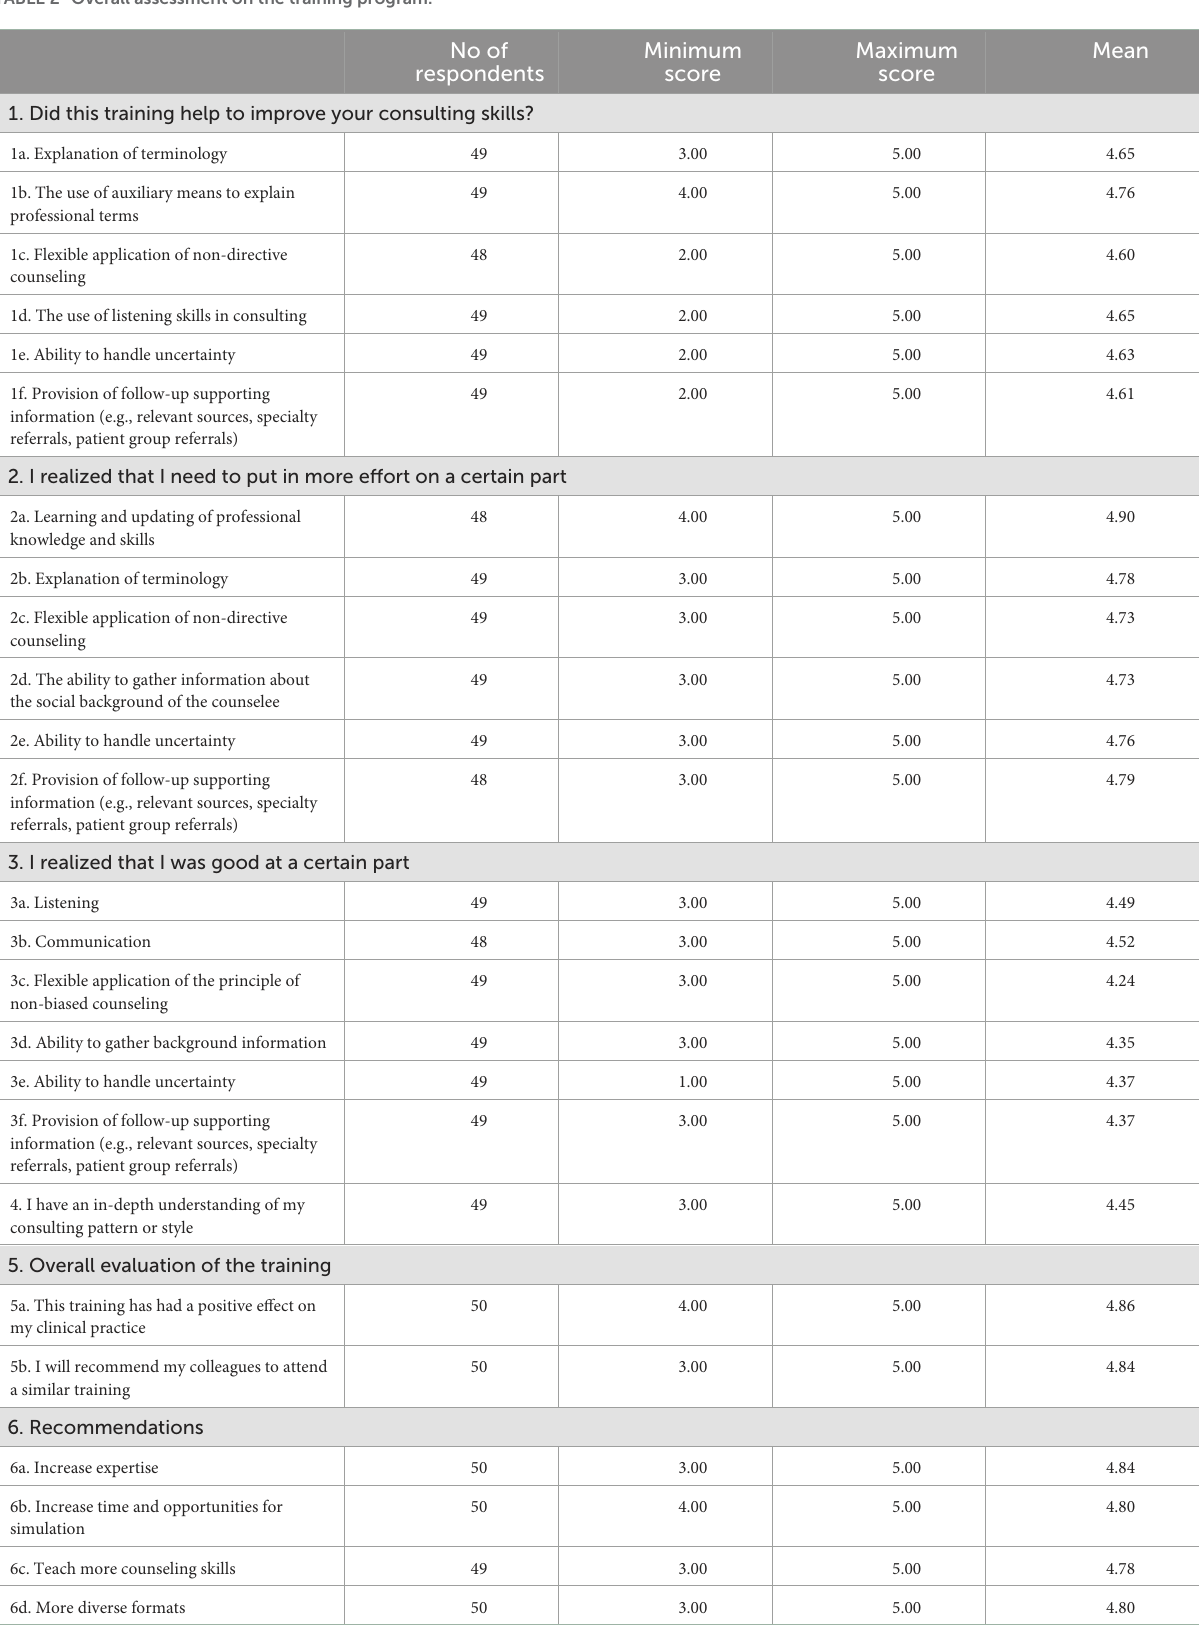
TABLE 2 Overall assessment on the training